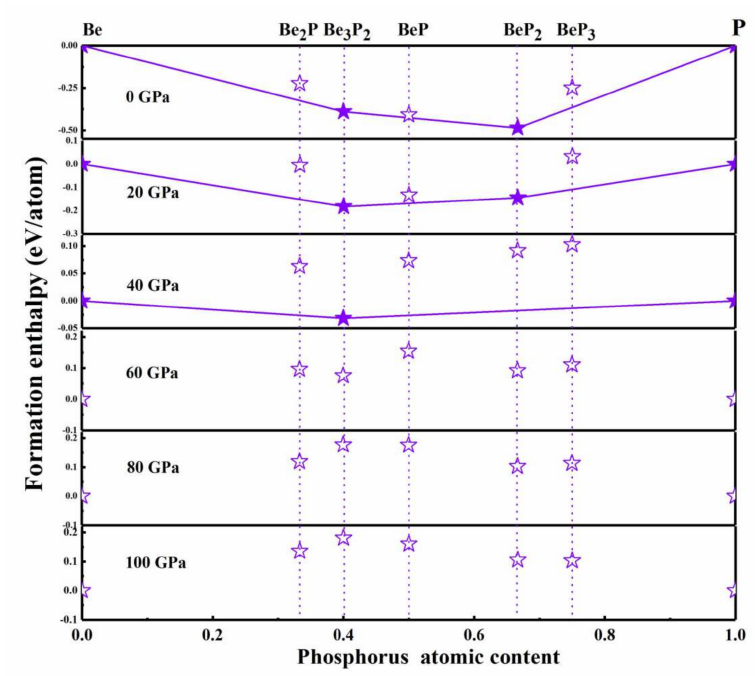
Figure 1. (color online). In relation to elemental beryllium and phosphorus solids, relative enthalpies of creation of the Be − P phase. Solid lines connect the stable phases to form convex shells (solid stars). Open stars indicate the unstable/meta stable